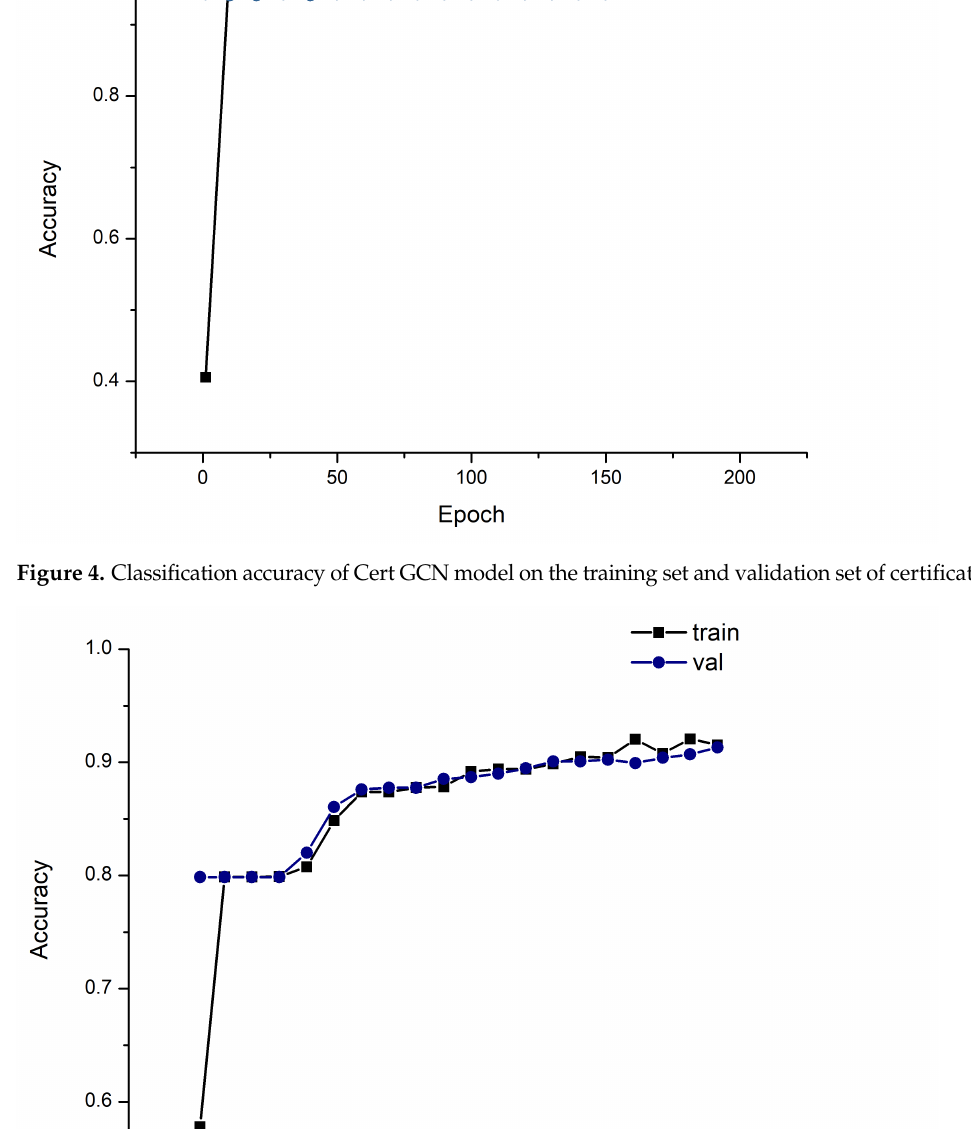
model. The fitting speed of Text GCN is slower than that of Cert GCN and the accuracy is not as high as that of Cert GCN. Figures 6 and 7 show the visualization of certificate node classification after training the